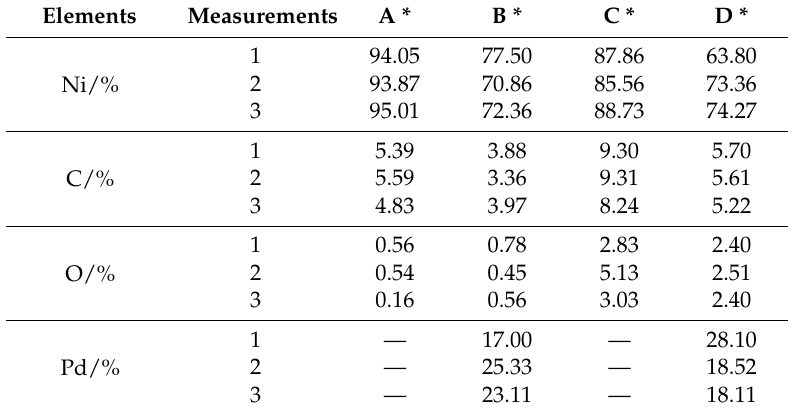
Table 1. EDX-derived surface elemental compositions for Ni foam and Pd-modified Ni foam samples.